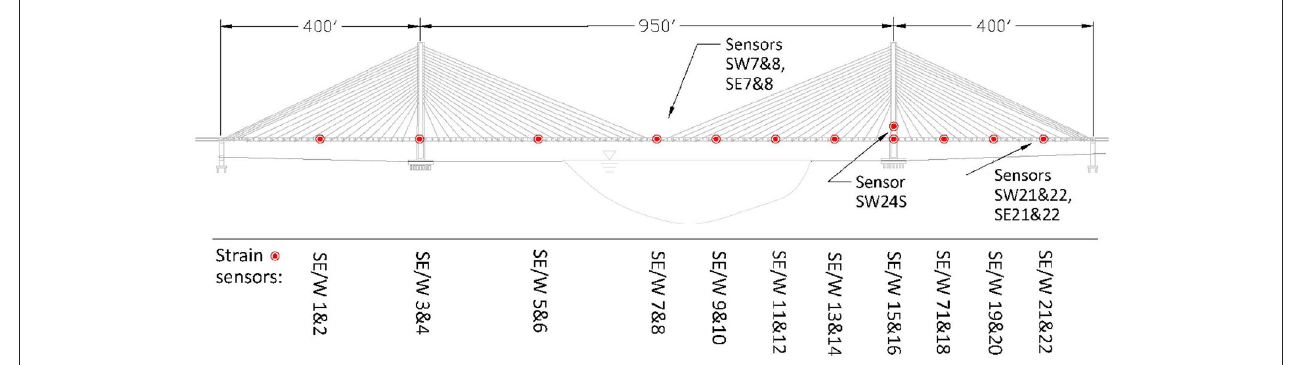
FIGURE 2 | Key strain sensors on edge